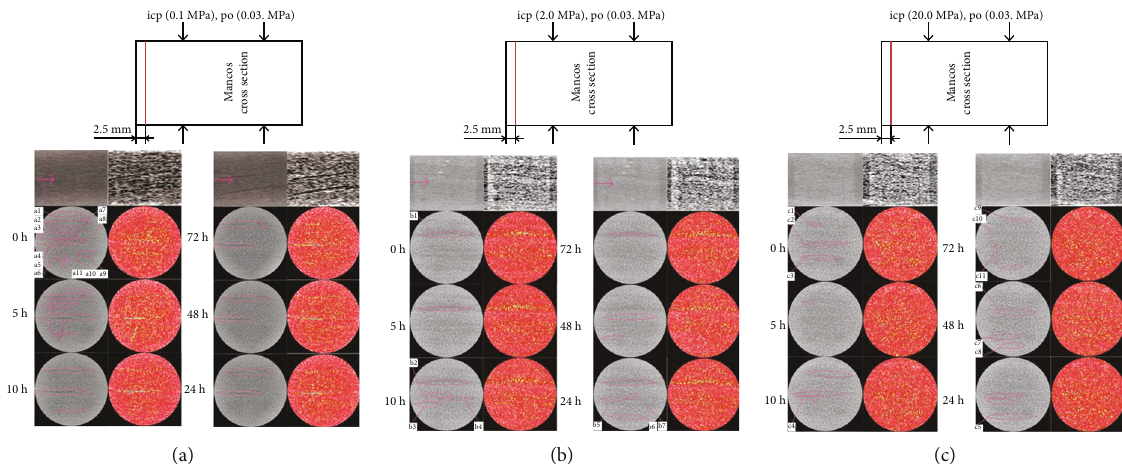
Figure 10: CT images of Mancos shale samples at di ff erent con fi ning pressures. ICP means con fi ning pressure. PO means injected fl uid pressure or pore pressure [78].